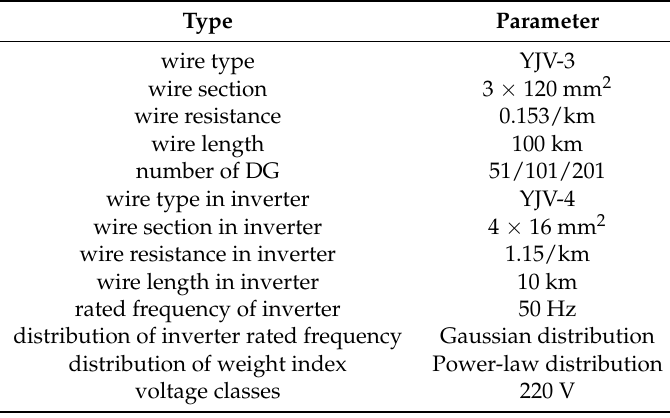
Table 2. Related parameters in Case